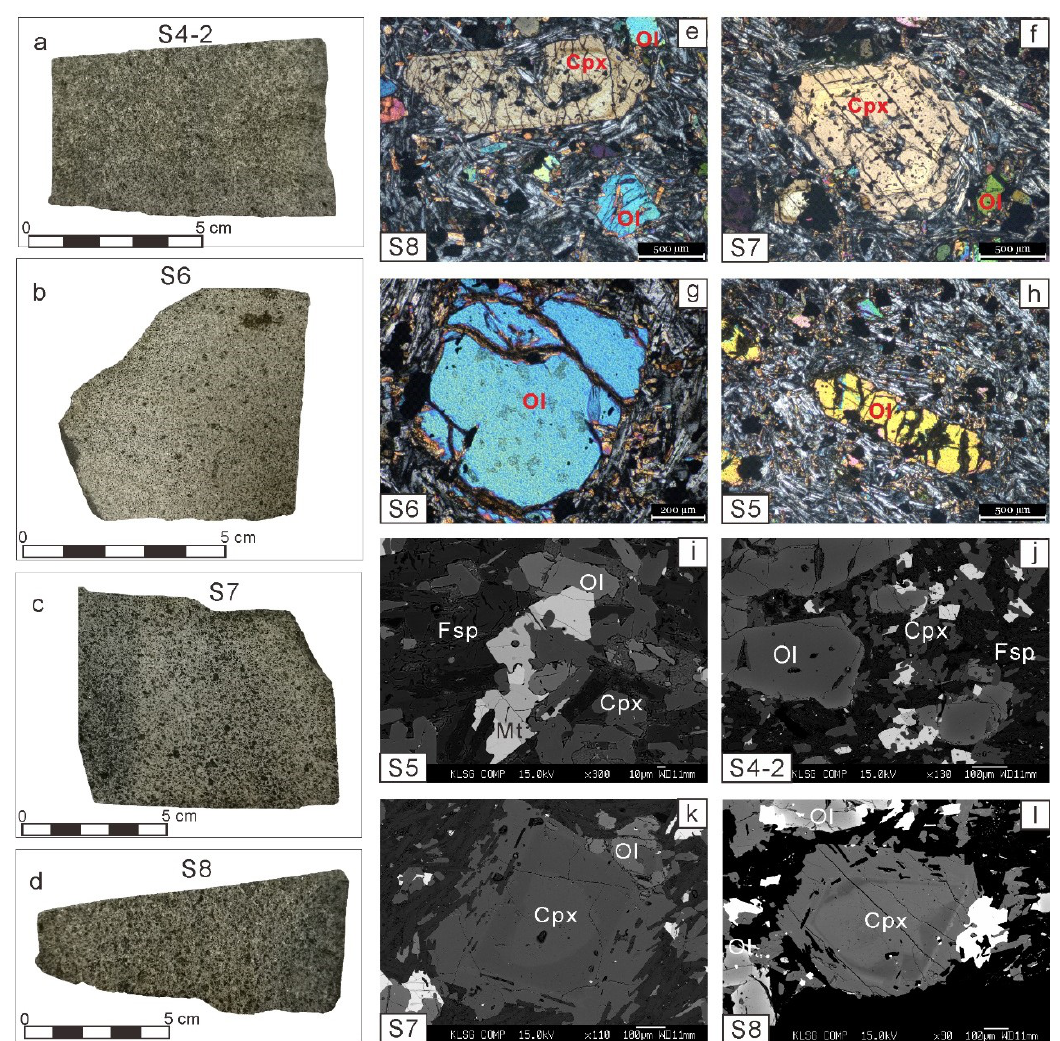
Figure 2. Hand specimens ( a – d ), photomicrographs showing textural and mineralogical characteristics ( e – h ), and back-scattered electron (BSE) images ( i – l ) of lavas from Pohnpei Island. Abbreviations: Ol, olivine; Cpx, clinopyroxene; Fsp, feldspar.